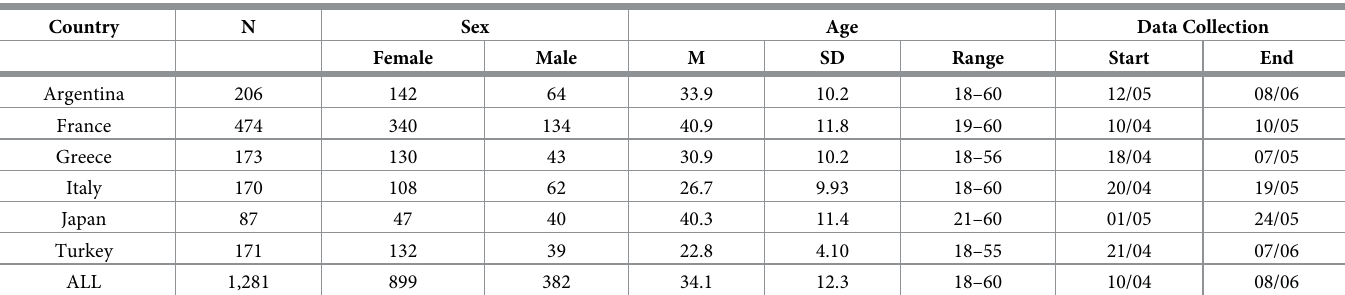
Table 1. Demographic information on the sample, subdivided by country. Country